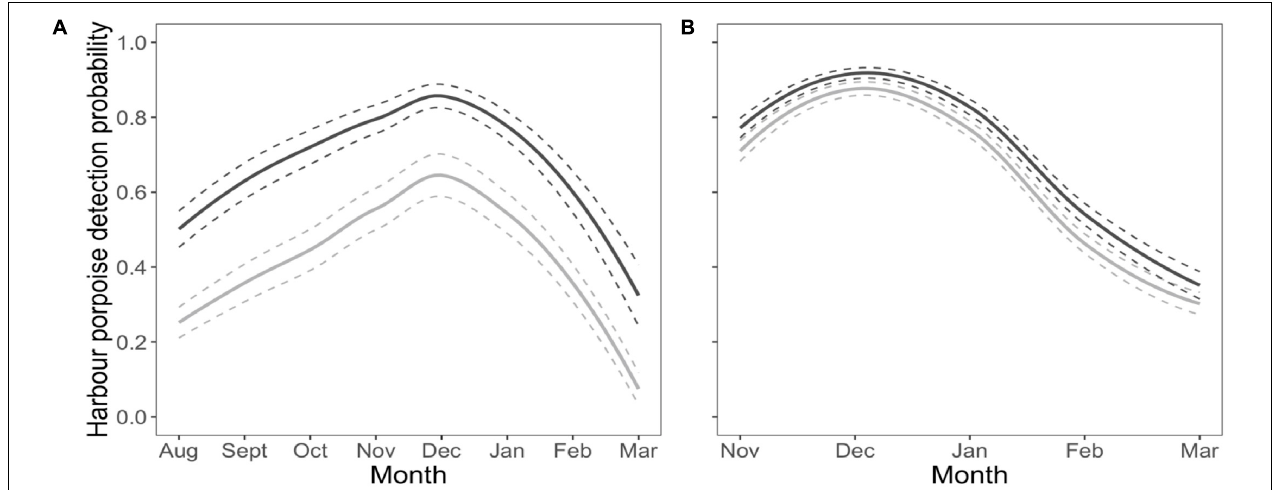
FIGURE 3 | Habituation. Temporal variation of the probability of detecting harbour porpoises as a function of pinger activity (dark gray line: pinger off; light gray line: pinger on) at the near C-POD (A) and at the remote C-POD (B) . Solid lines denote predictions from top ranked models presented in Table 1 . Standard errors are shown by the colored dashed lines.